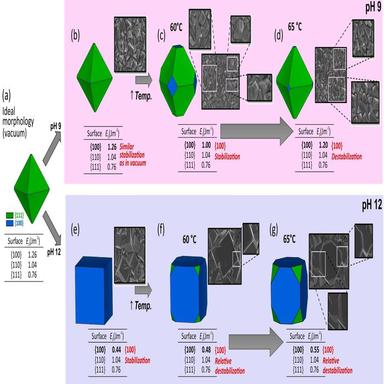
(a) Morphology diagrams starting from the ideal morphology by Wulff's construction method in a vacuum condition, and the change paths according to the surfaces stabilizations of the Cu2O thin films deposited at (b) pH 9/55 ◦C, (c) pH 09/60 ◦C, and (d) pH 09/65 ◦C, (e) pH 12/45 ◦C, (f) pH 12/60 ◦C, (g) pH 12/65 ◦C.